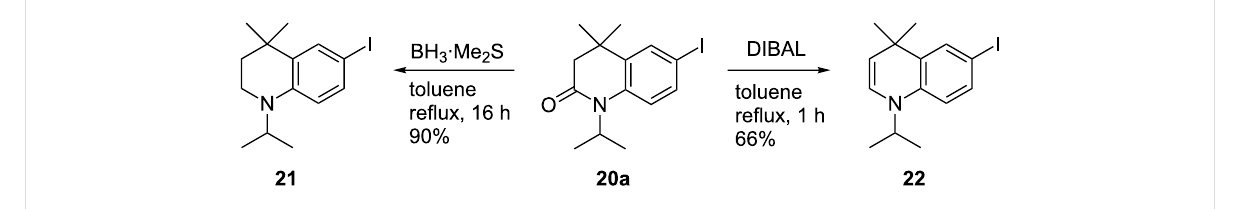
Scheme 8: Synthesis of THQ 21 and DHQ 22 using borane·dimethyl sulphide complex or DIBAL, respectively.